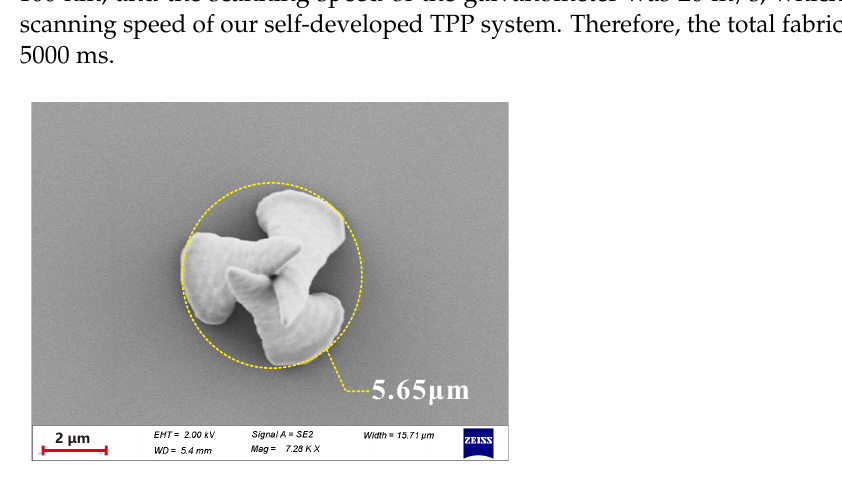
Figure A1. SEM photo of 3D chiral microstructure fabricated by conventional point-by-point scan- ning